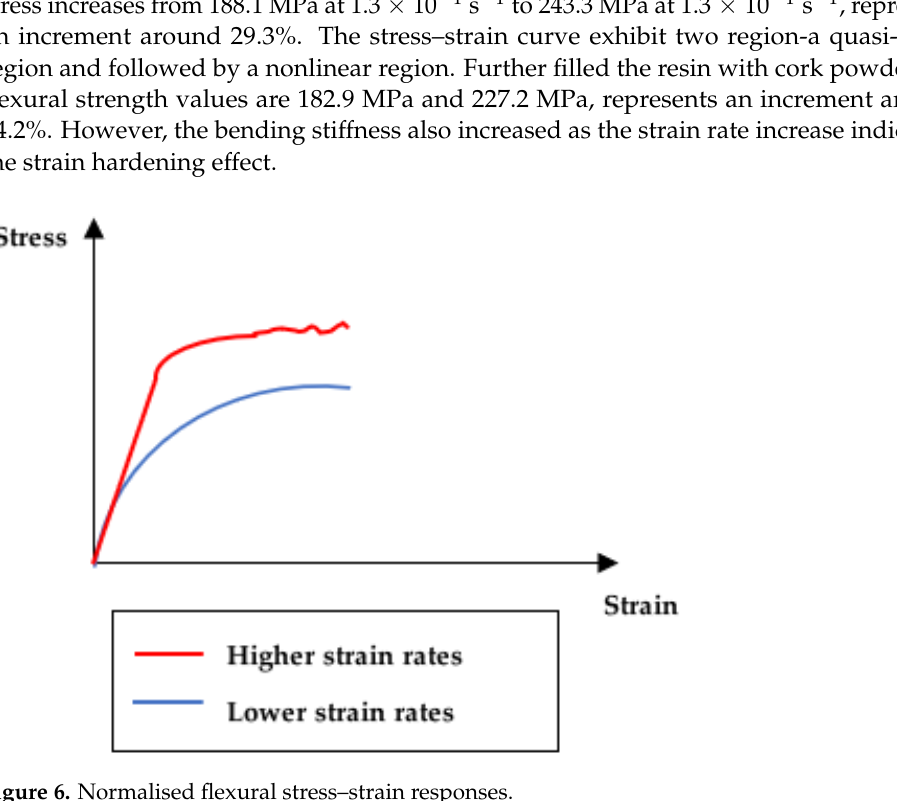
Figure 6. Normalised flexural stress–strain responses.